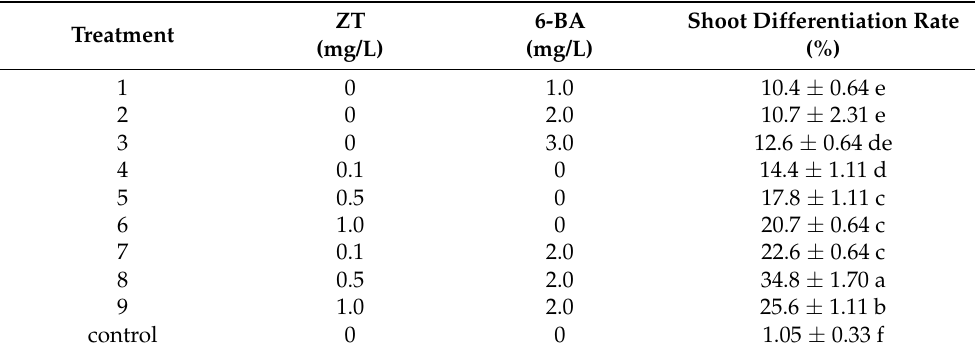
Table 3. The effects of combinations of zeatin (ZT) and 6-BA on shoot differentiation from flower petals after 4